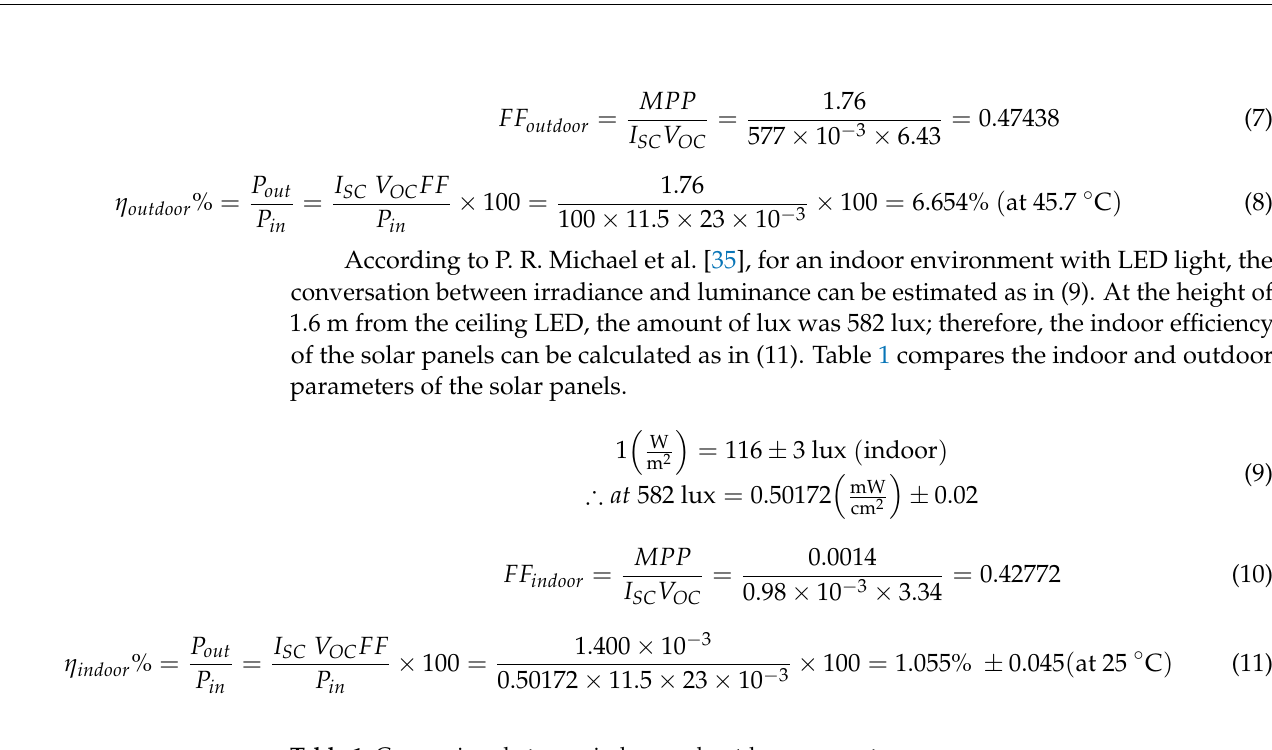
Table 1. Comparison between indoor and outdoor